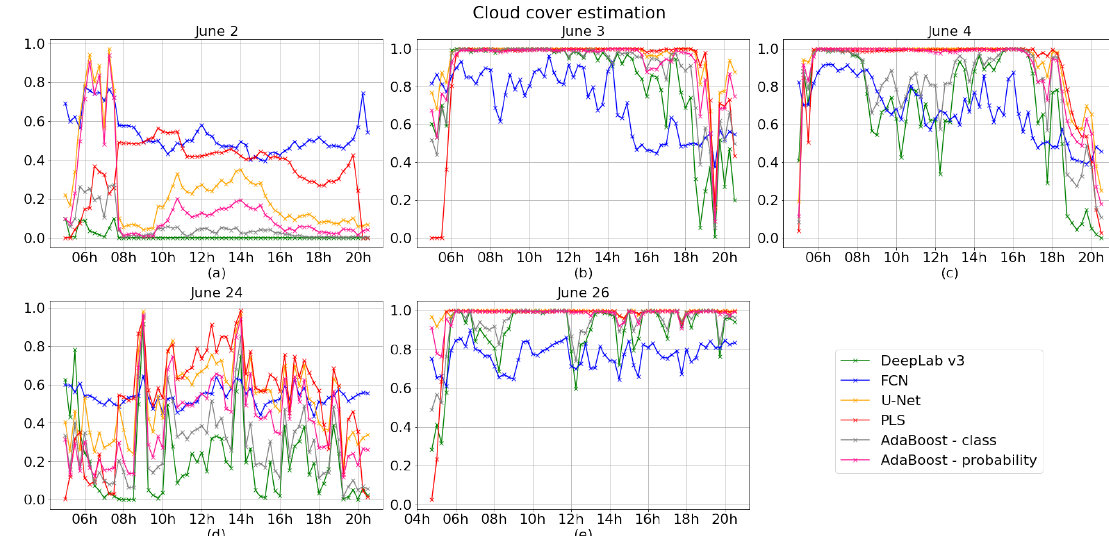
Figure 4. Results of 15 min averaged cloud cover estimation. The results show ratios of cloud pixels in images at each time point. If no cloud pixel was detected, the ratio was calculated as 0; if the whole sky was covered with cloud, the ratio was calculated as 1. The results are shown for the cloud types ( a ) clear sky, ( b , c ) haze clouds, ( d ) partially cloudy sky, and ( e )